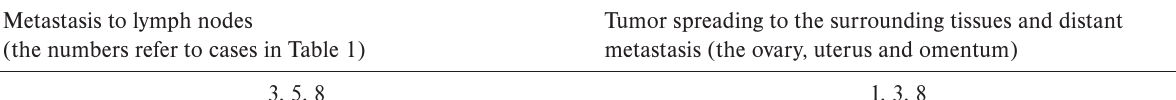
Table 2. Metastasis to lymph nodes and distant